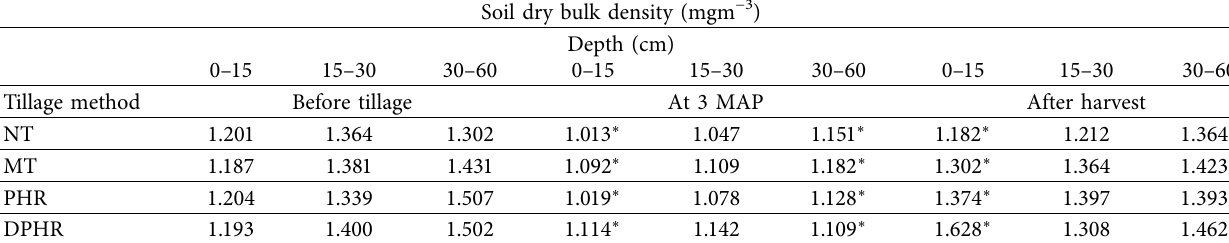
Table 2: Tillage method’s effect on soil dry bulk density.